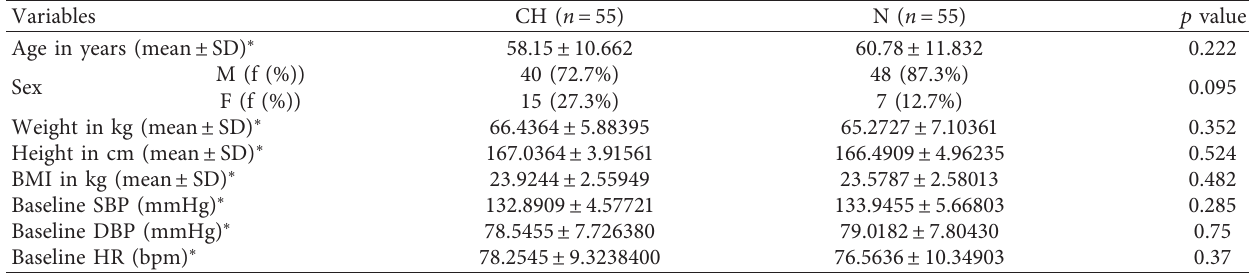
Table 1: Comparison of demographic data and baseline hemodynamic parameter between the two groups: Black Lion hospital from October 30, 2019, to January 30, 2020.